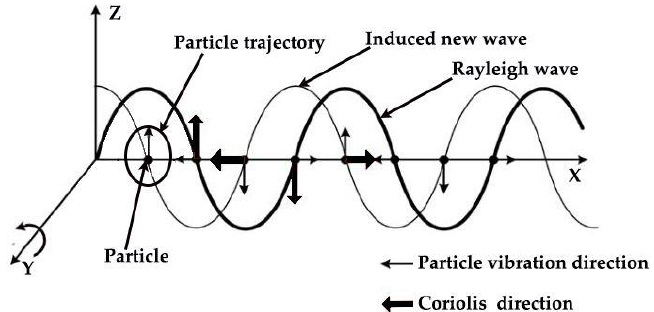
Figure 1. Schematic of the gyroscopic effect on the Rayleigh wave.